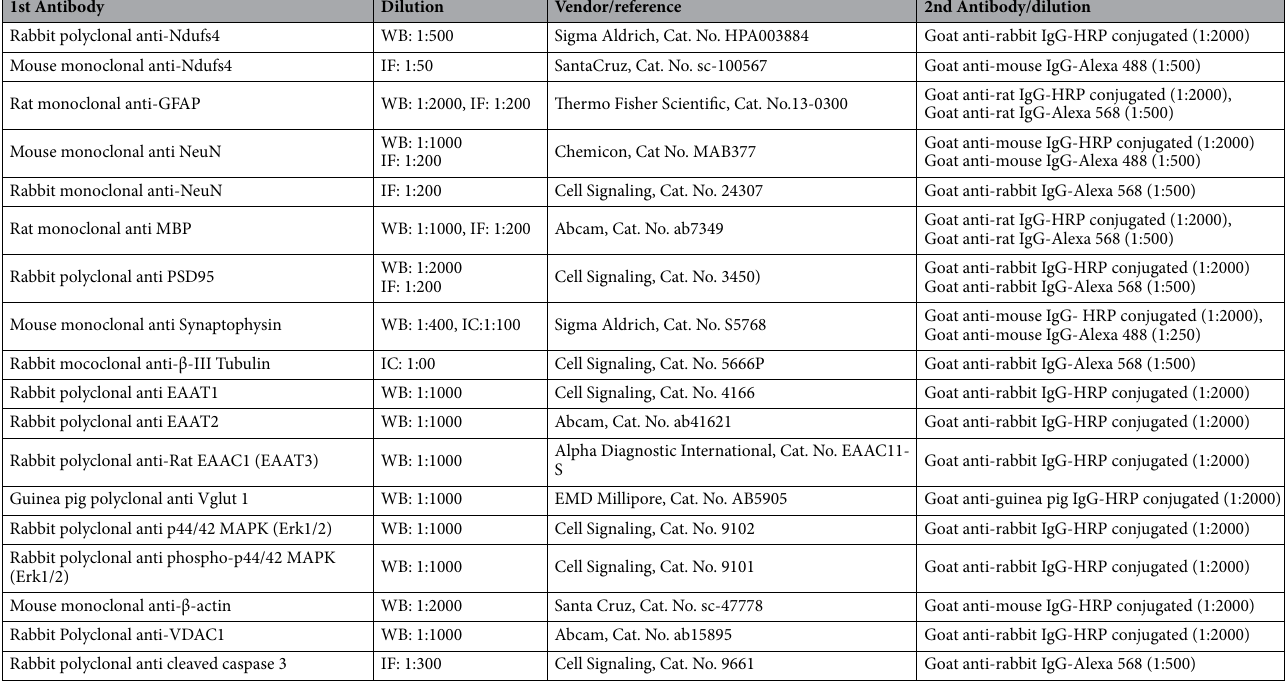
Table 1. List of primary and secondary